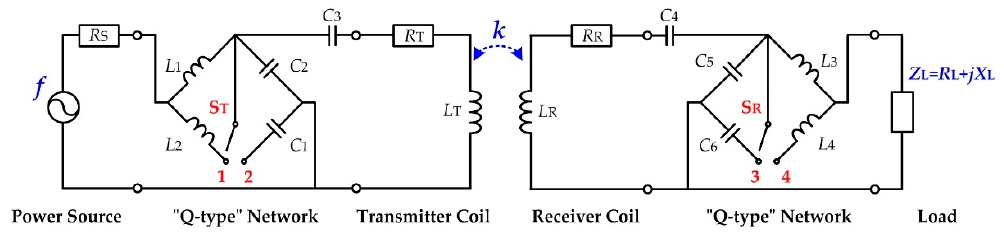
Figure 4. Structure of the modified WPT system.